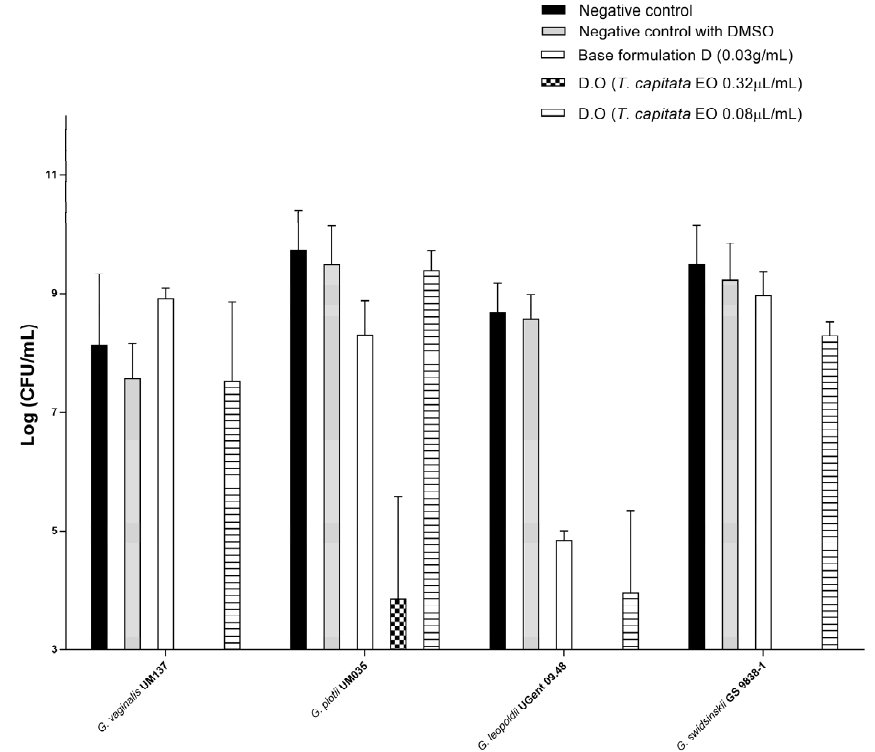
Figure 6. Effect of vaginal sheet D.O with TCEO on biofilms of four different species of Gardnerella at Figure 6. E ff ect of vaginal sheet D.O with TCEO on bio fi lms of four di ff erent species of Gardnerella 0.32 µ L/mL, 0.16 µ L/mL and 0.08 µ at 0.32 µL/mL, 0.16 µL/mL and 0.08 µL/mL.